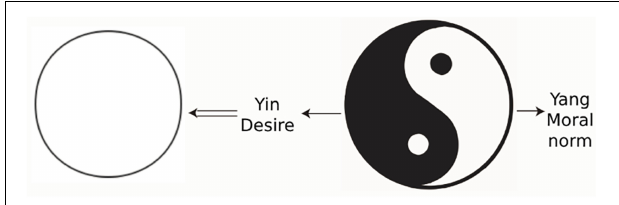
FIGURE 5 | Confucian mental health definition model.